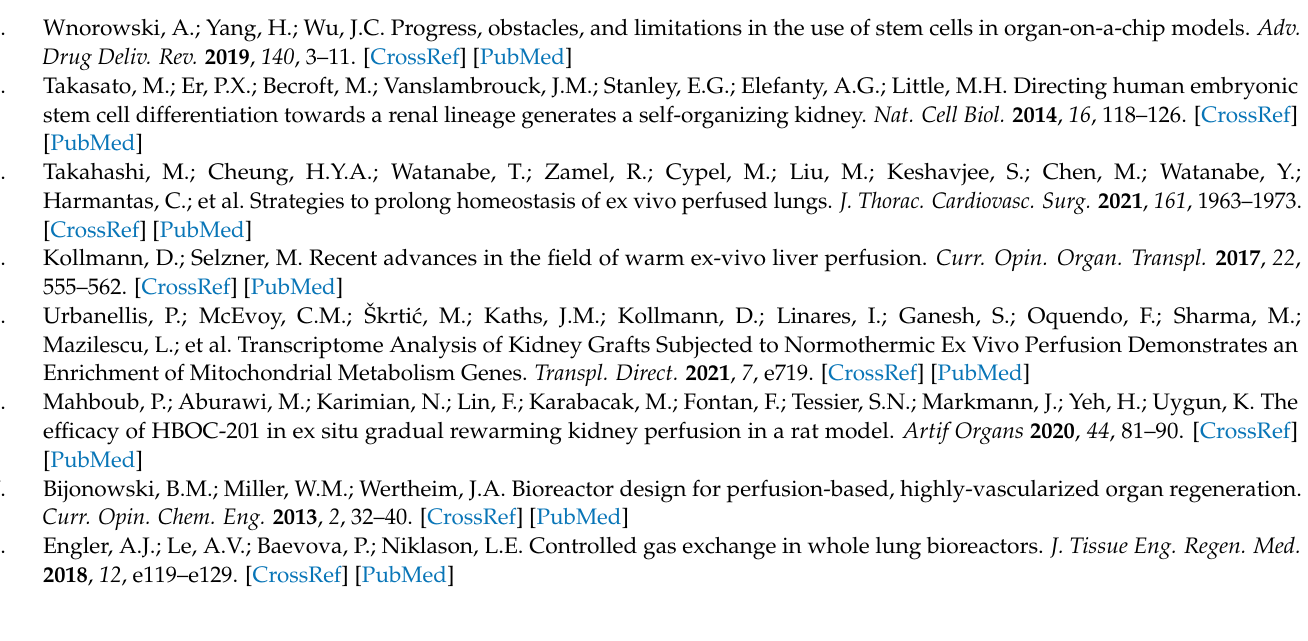
Error Function table. Supplementary Figure S1: PAS and TUNEL staining of an ex vivo perfused mouse